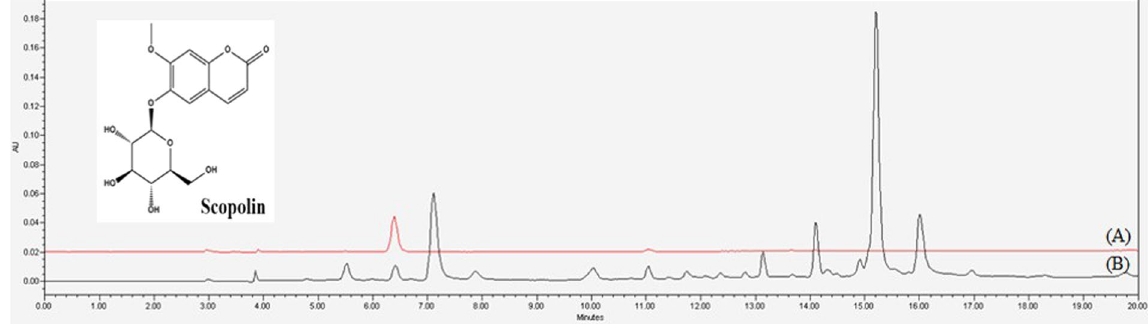
Figure 1. HPLC chromatogram and chemical structure of scopolin. ( A ) HPLC chromatogram of the isolated compound scopolin and its structure. ( B ) HPLC chromatogram of Artemisia iwayomogi